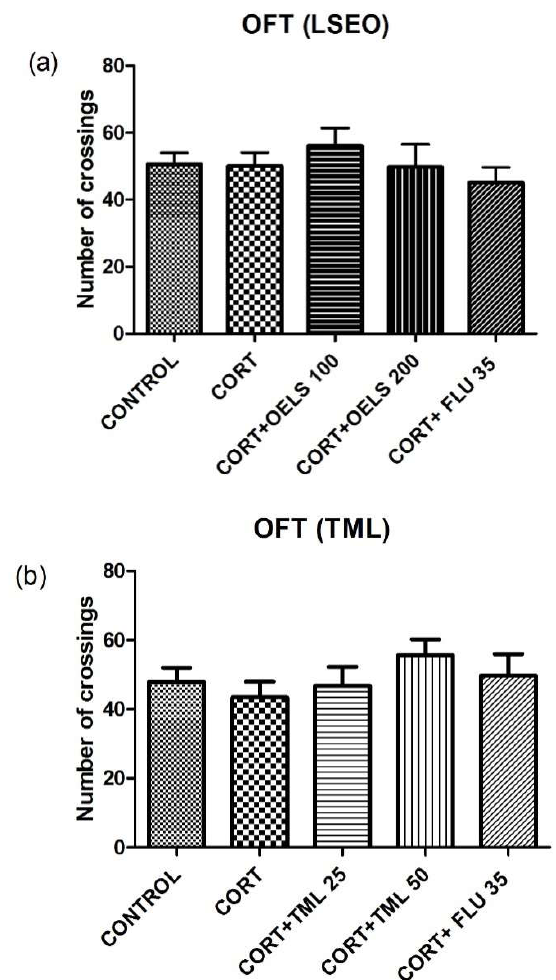
Figure 5. Effects of repeated administration of ( a ) LSEO (100 and 200 mg/kg; p.o.) and ( b ) TML (25 and 50 mg/kg; p.o.) in animals treated with CORT (22 days, 20 mg/kg, s.c.) on the number of crossings on the OFT. Values are expressed as the mean ± SEM ( n = 10). Statistical analysis was determined by one-way ANOVA followed by the Student-Newman-Keuls test. There are no significant values vs. CORT. LSEO = Lippia sidoides essential oil; TML = thymol; CORT = corticosterone; OFT = open field